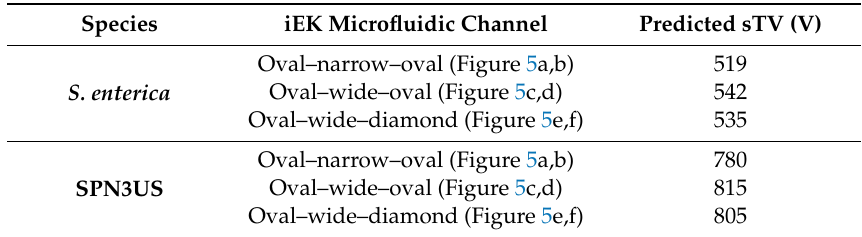
Table 2. Predicted sTV values for S. enterica and SPN3US in each insulator-based electrokinetic (iEK) microfluidic